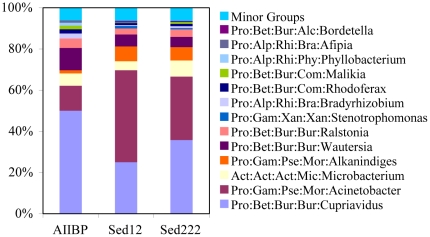
Microbial communities in the three samples.The 16S fragments obtained from the reads were classified in the RDP database. The confidence threshold was not used in the classification. The genus with the highest confidence level was therefore assigned to the fragment. The average confidence level for genera is listed in Table S2. Only genera occupying >1% in one or more samples were included in the figure. All the remaining genera were included in minor groups.